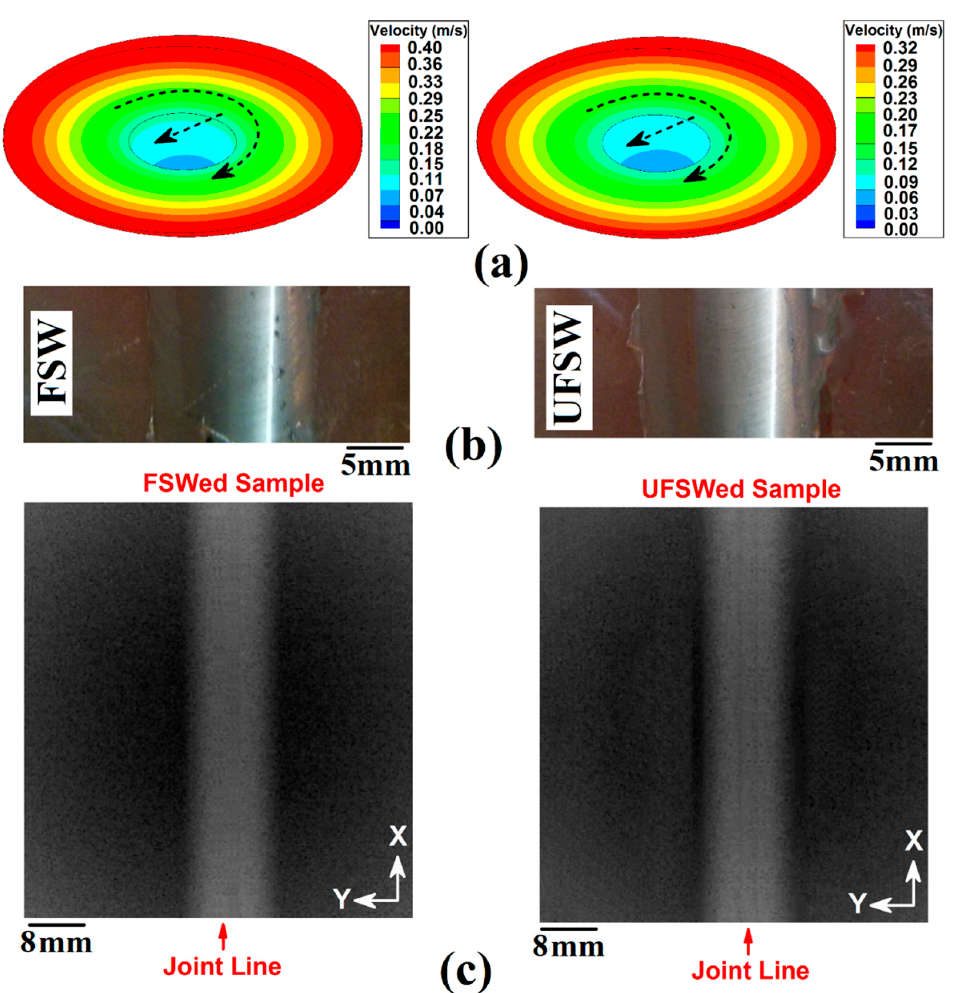
Figure 5. ( a ) Material velocity result from simulation in the SZ of underwater-FSWed and FSWed samples. ( b ) Surface flow of joint lines in both cases. ( c ) Radiography NDT results of joint lines.